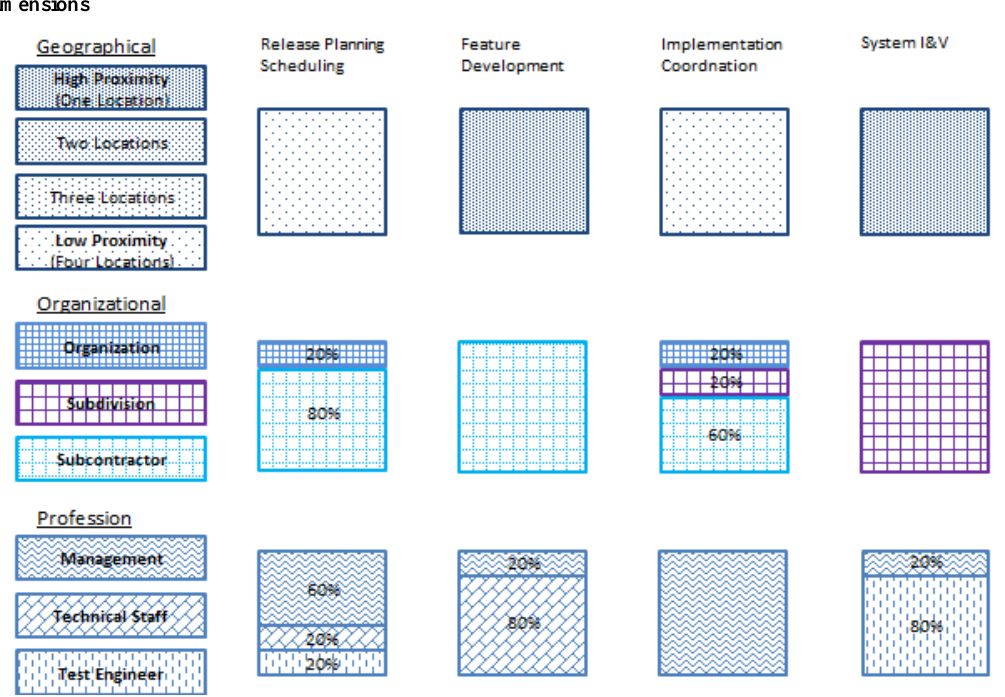
Figure 8. Dimensions of heterogeneity of functional